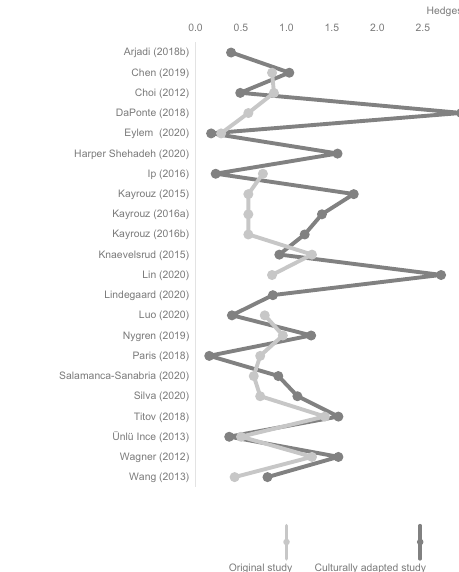
Fig. 3 Effect sizes (Hedges ’ g ) of the culturally adapted versus original internet- and mobile-based interventions. Twenty-two included articles provided relevant information on the effect of their intervention. If more than one primary outcome was reported, the effect size of the Patient Health Questionnaire 102 is illustrated. Both single group studies and randomised controlled trials are included. Full information on the respective effect sizes can be found in Table